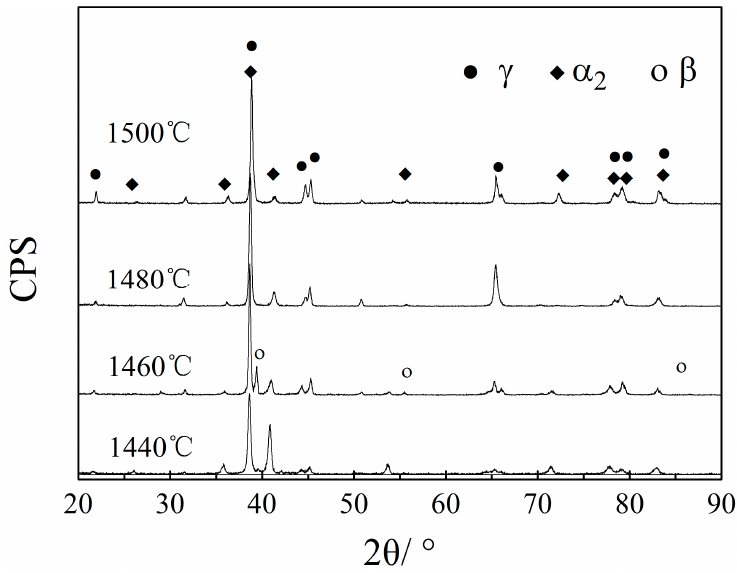
Figure 7. The XRD patterns of the samples sintered at different temperatures.